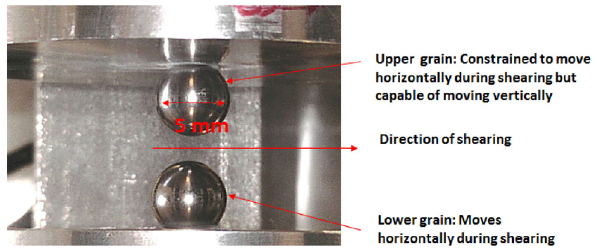
Fig. 4 Image captured by a digital microscope camera during the setting of an experiment on chrome steel balls on the large-size micromechanical